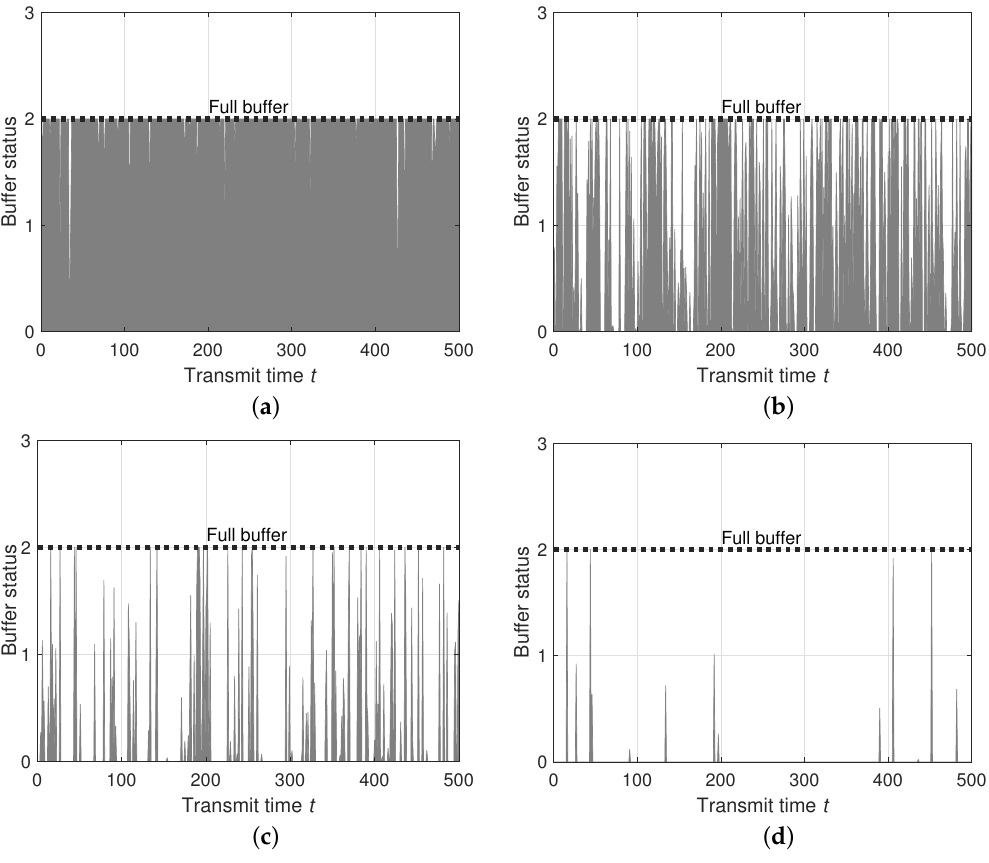
Figure 2. Buffer status when γ sr = 10 dB and buffer size is two bits, i.e., b = 2. ( a ) γ rd = 0 dB. ( b ) γ rd = 10 dB. ( c ) γ rd = 15 dB. ( d ) γ rd = 25